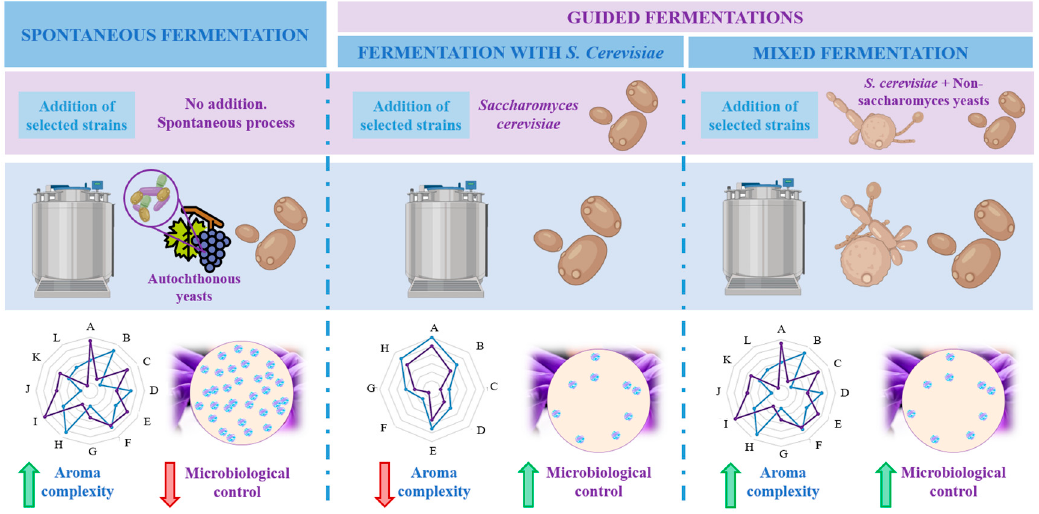
Figure 1. Schematic representation of the types of fermentation, the implied yeasts and the final characteristics of the obtained wine according to aroma complexity and microbiological control. Based on Reference [19].